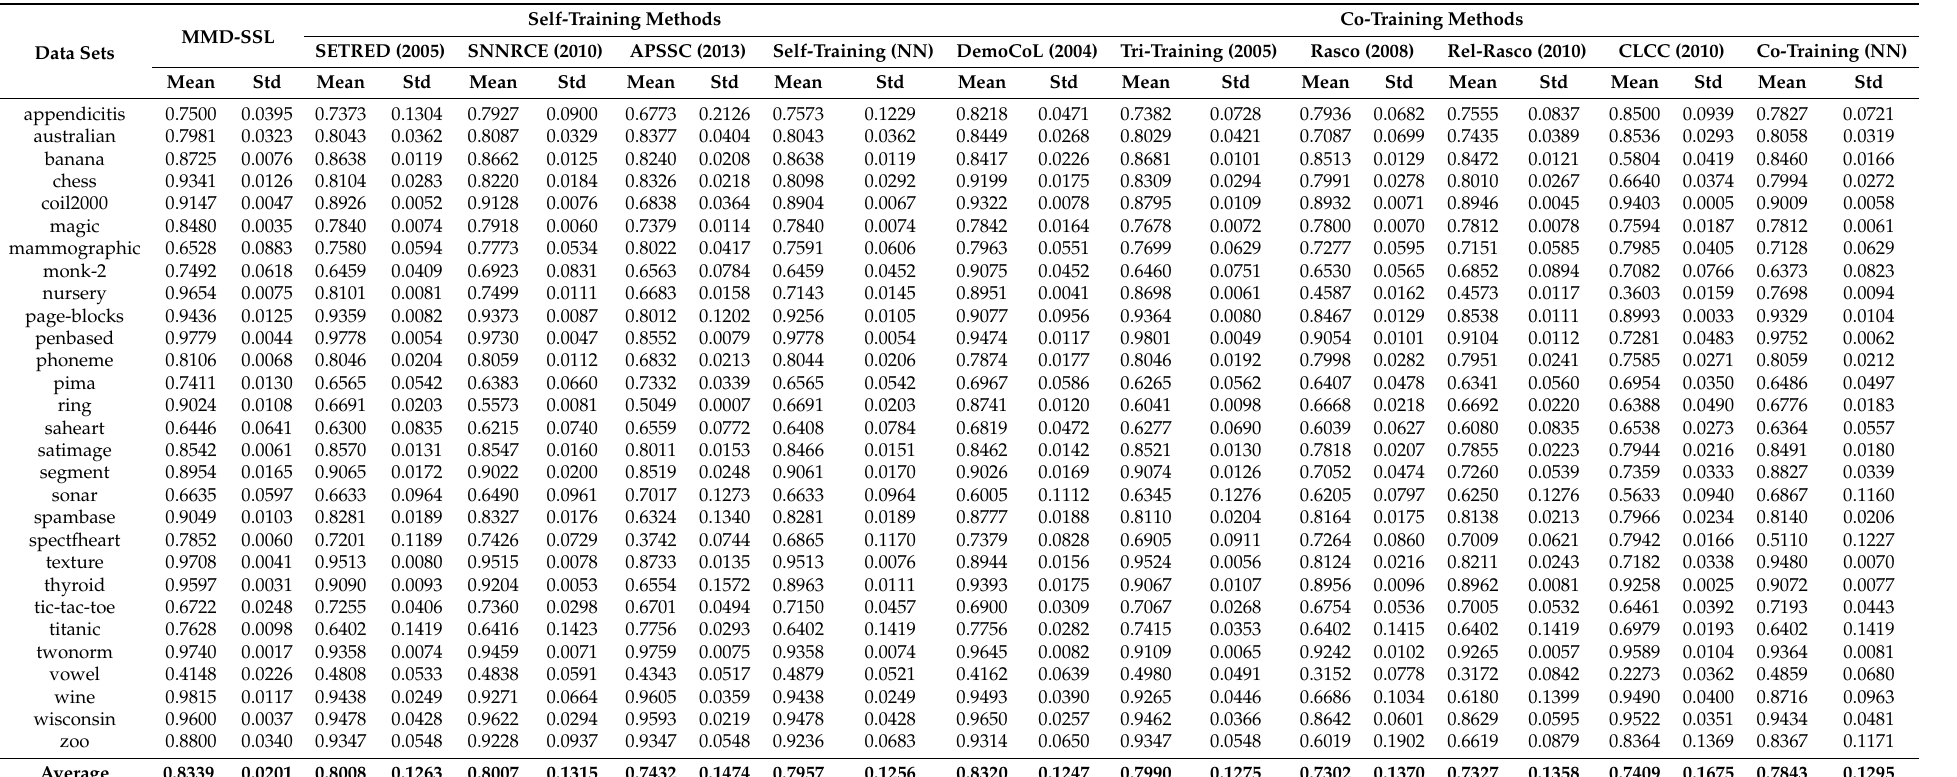
Table 3. Accuracy comparison of MMD-SSL and 10 other SSL algorithms on 10% labeled